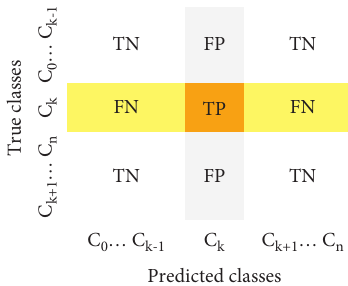
Figure 11: Simple illustration of a confusion matrix with multiple classes.